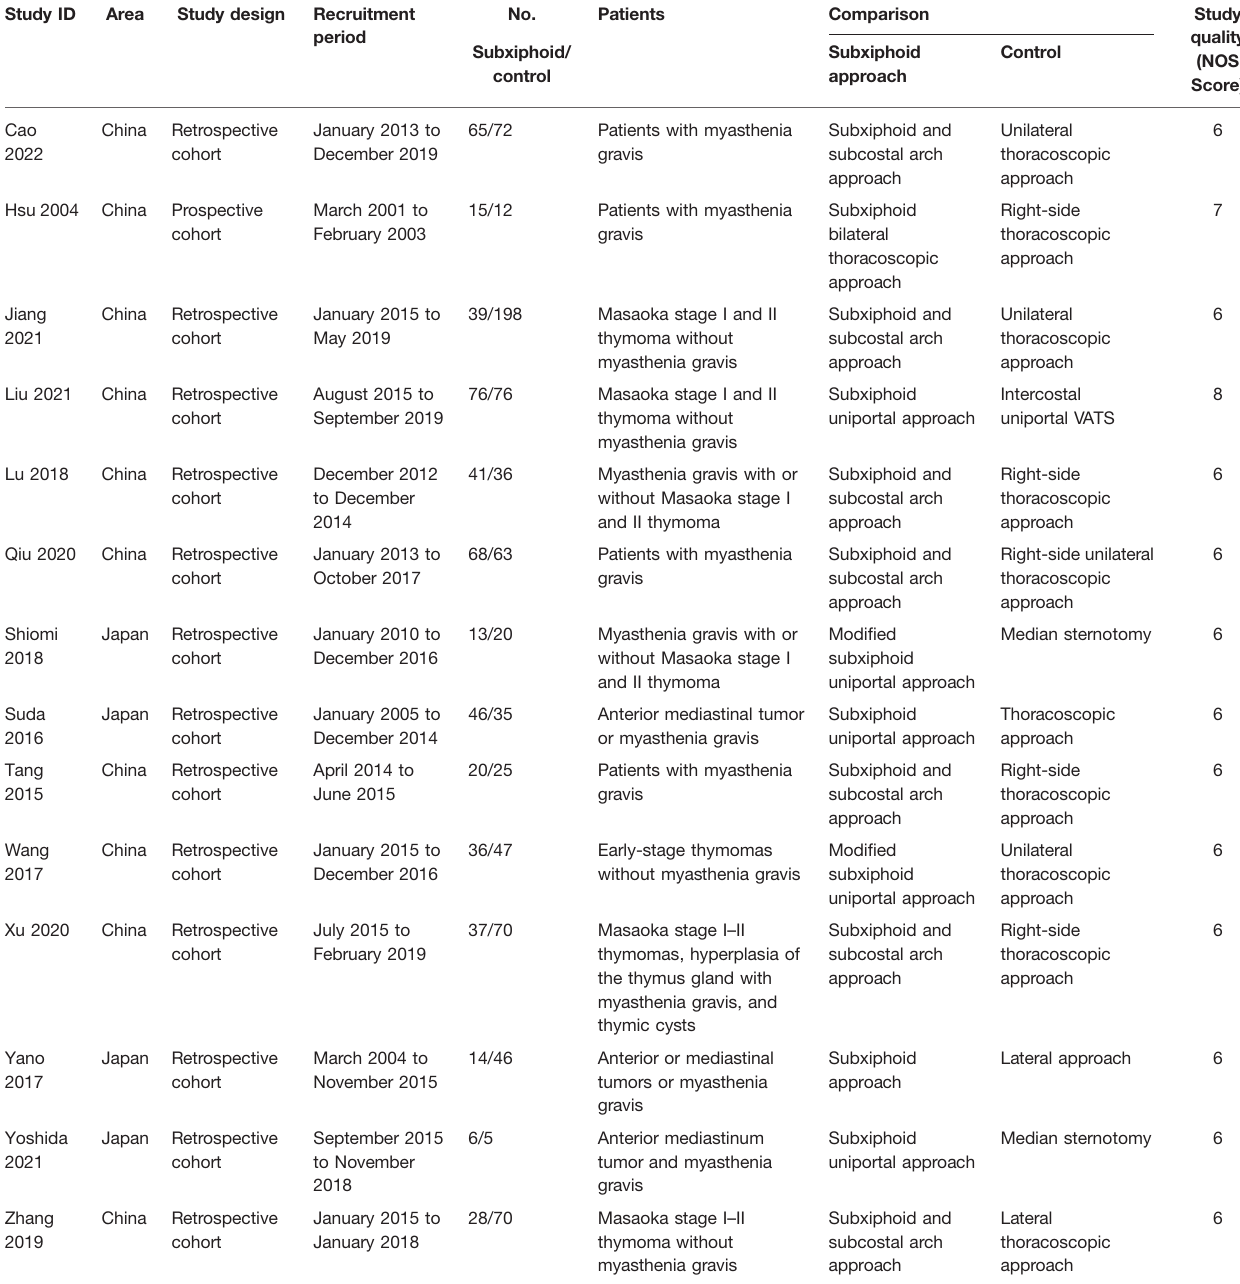
TABLE 1 | Baseline characteristics of included